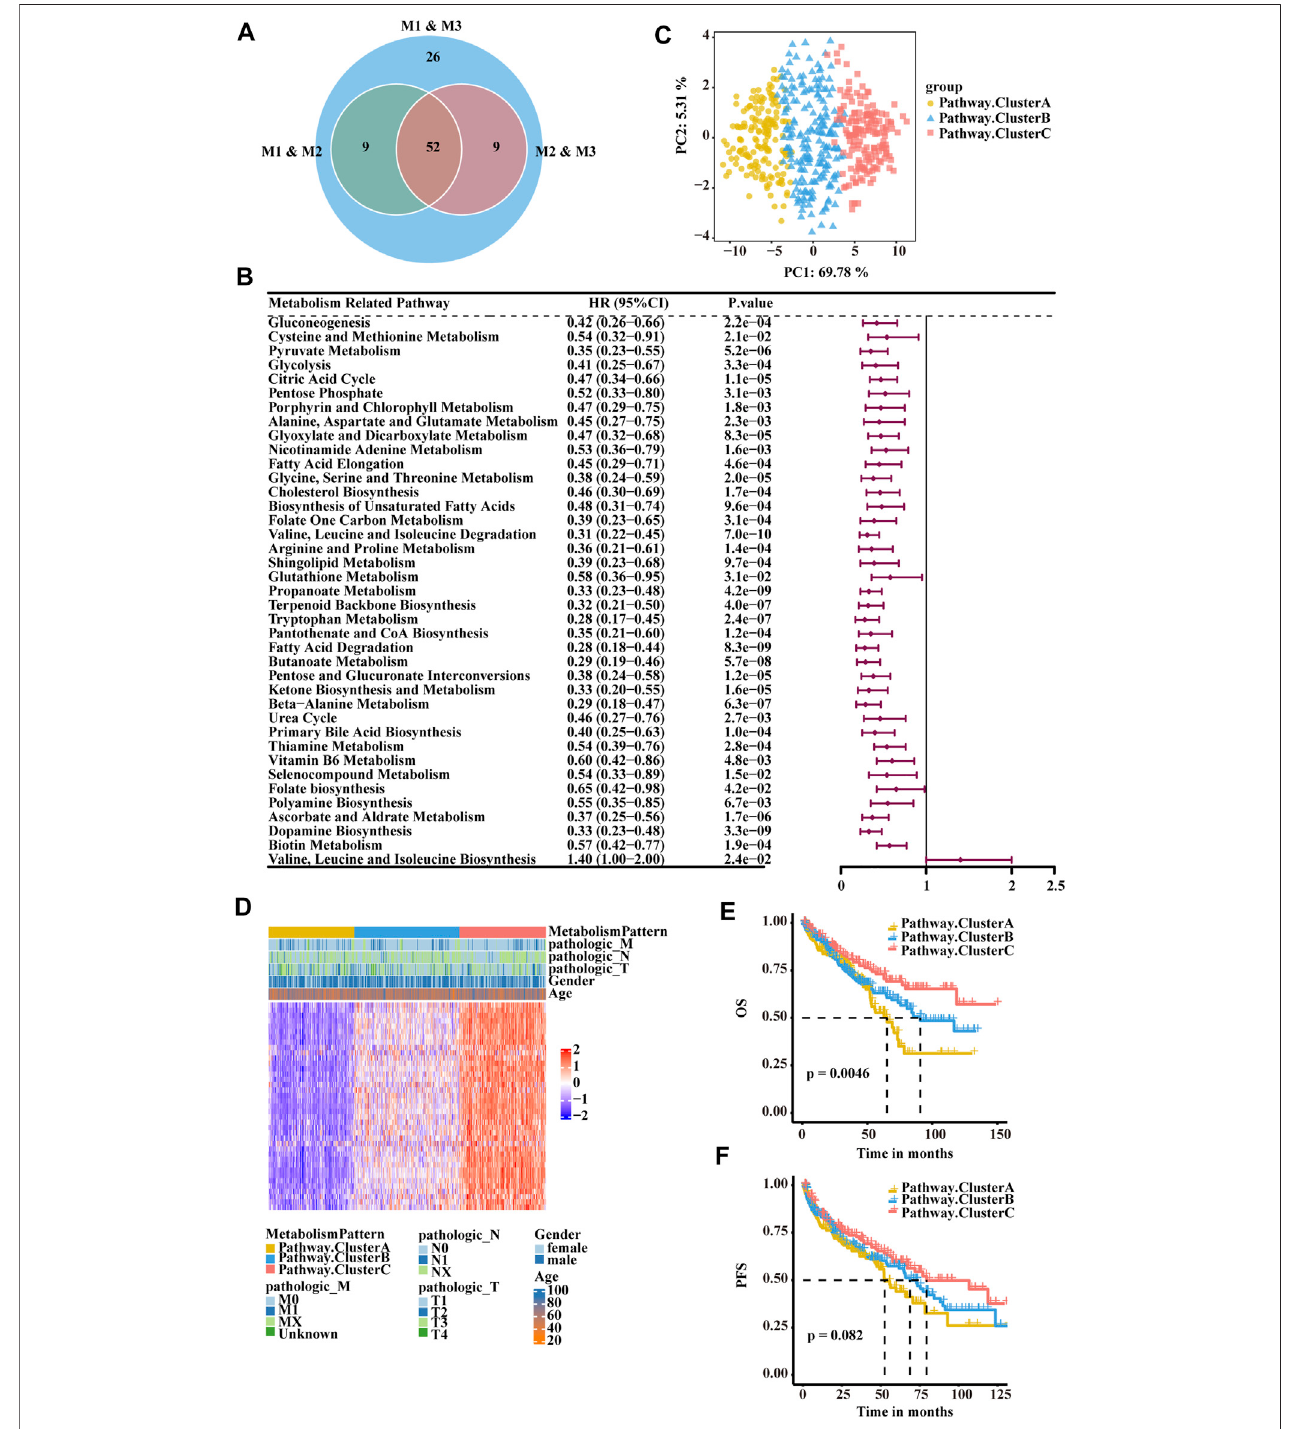
FIGURE3| Classi fi cationofRCC clustersbasedondifferentialmetabolism-associated pathways. (A) Venndiagramillustratingthenumberofdifferentialpathways amongthe threemetabolismpatterns. (B) Forest plots showing thesigni fi cantlyprognostic differential pathways identi fi edwithunivariate Coxregression analysisbased on OS. (C) Principal component analysis of thepathway activity of the three pathway clusters, showing a remarkable difference in pathway activity between thedifferent clusters. (D) Consensus clustering of prognostic differential pathways between the three pathway clusters in TCGA-KIRC. (E) OS analyses for the three pathway clusters based on patients with KIRC from TCGA cohorts. (F) PFS survival analyses for the three pathway clusters based on patients with KIRC from TCGA cohorts.